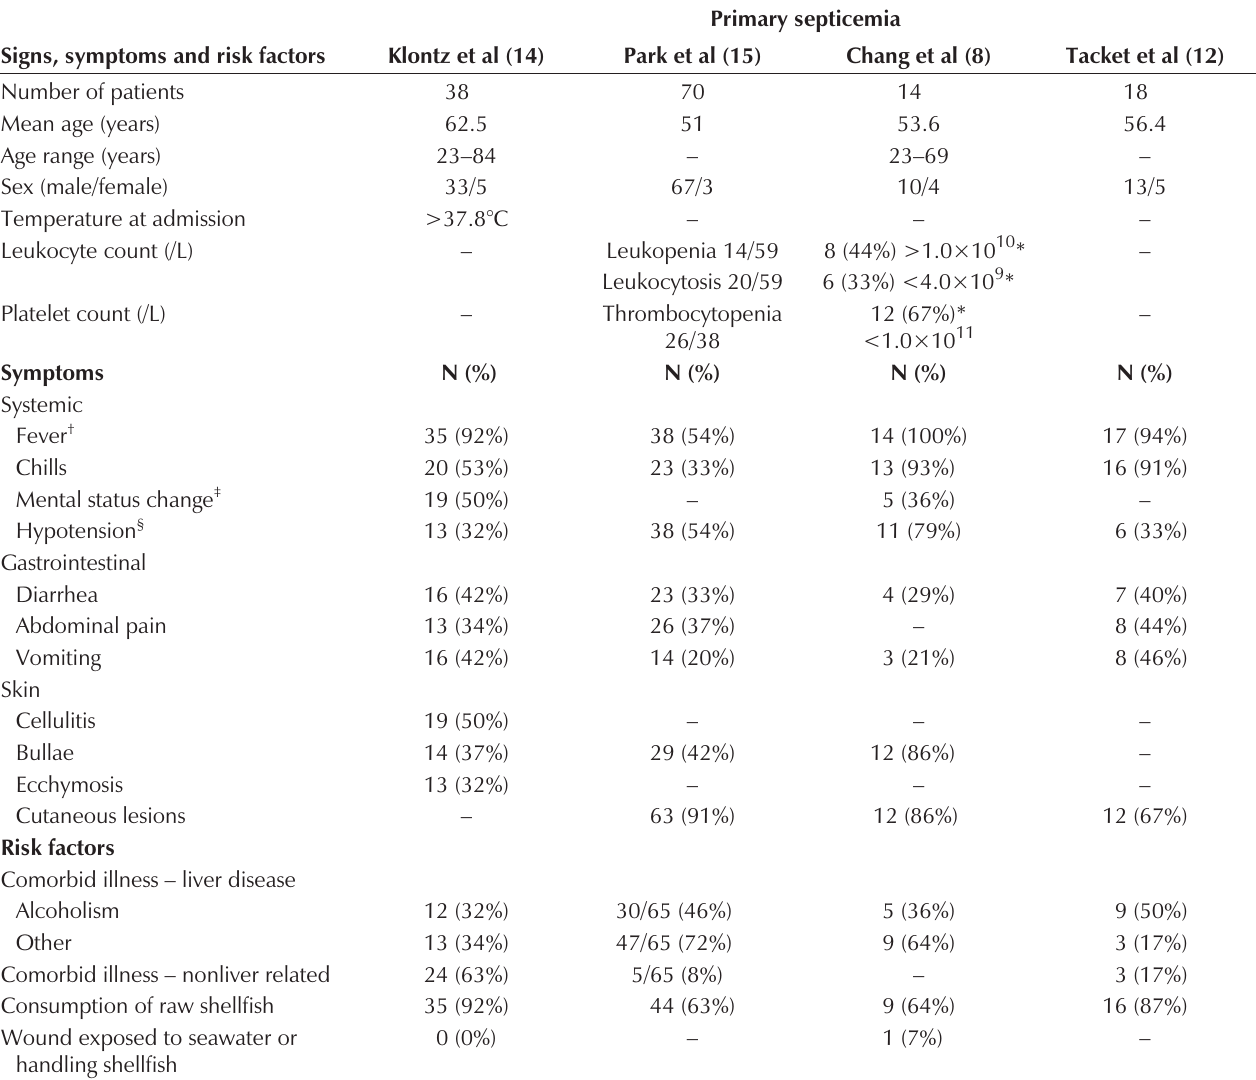
Primary septicemia